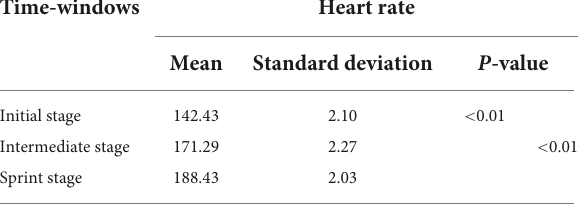
TABLE 3 Statistical analysis of participants in three time-windows.